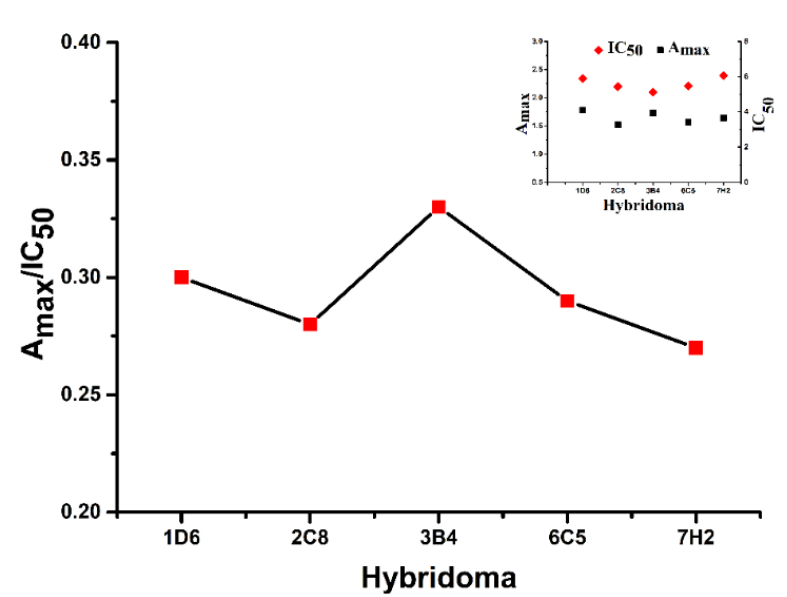
Figure 6. The screening results of hybridoma against endosulfan.